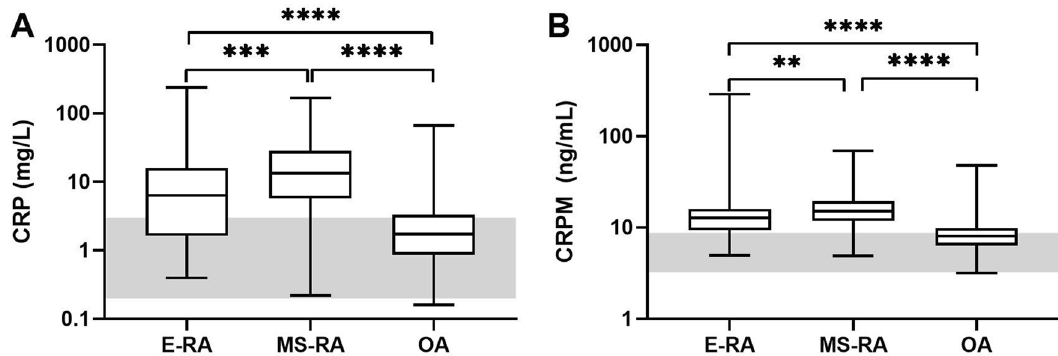
Figure 1. Baseline serum CRP and CRPM levels in early arthritis (E-RA), moderate to severe RA (MS-RA) and osteoarthritis (OA) patients compared to early RA patients. ( A ) Serum CRP levels and ( B ) serum CRPM levels. Grey vertical bars indicate the normal references ranges established in the central lab measuring the markers. Data are shown as IQR and differences are tested by ANCOVA using log transformed biomarker data adjusting for covariates (age, gender, race, VAS pain). Bonferroni corrected significance levels: ** p < 0.01 and **** p < 0.0001.